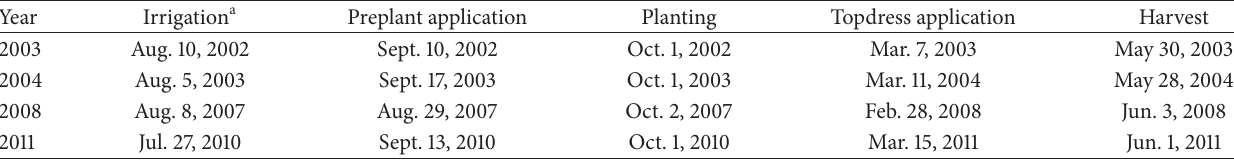
Table 2: Dates of agronomic activities for growing seasons utilized in this study.